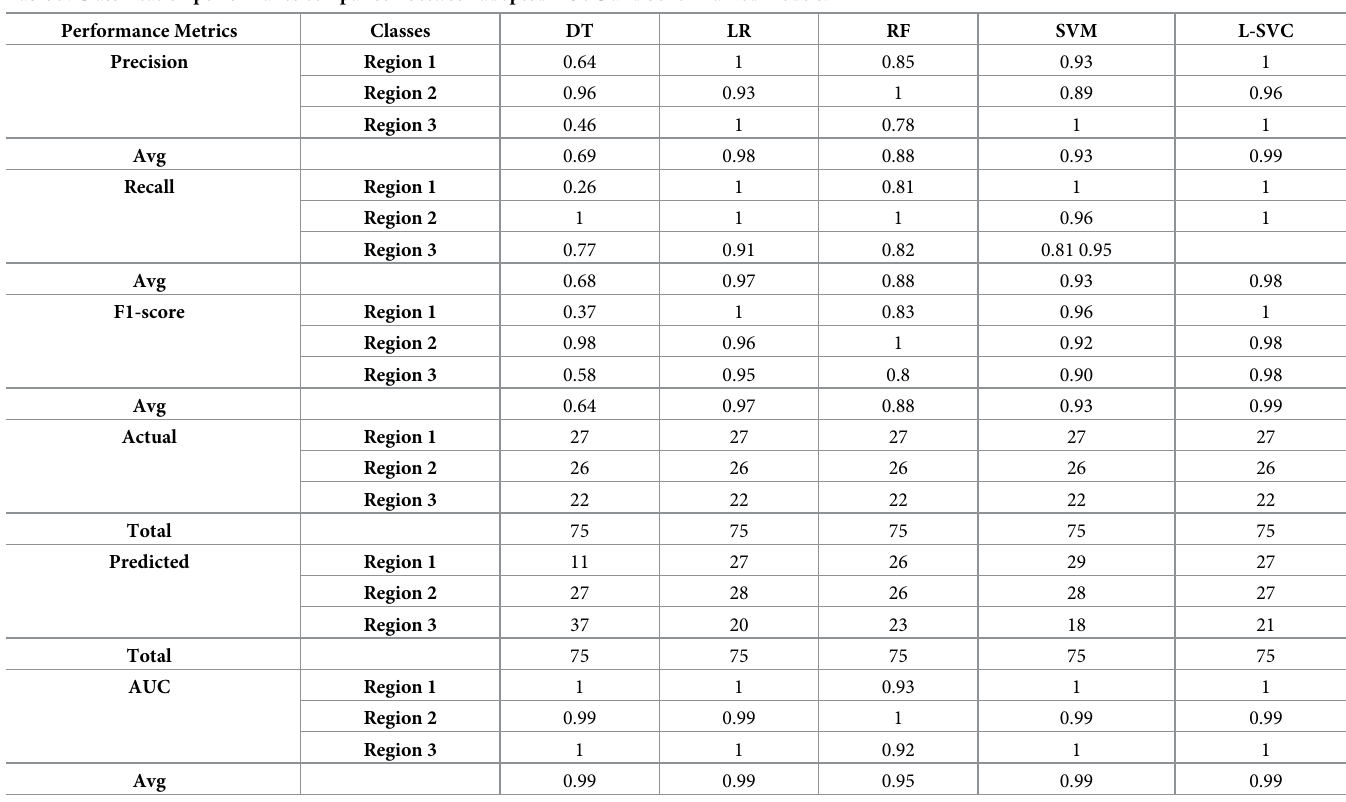
Table 7. Classification performance comparison between adopted L-SVC and benchmarked